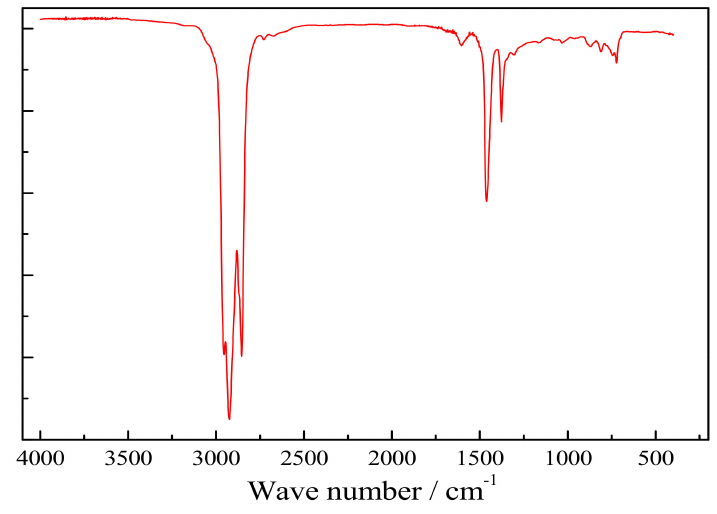
Figure 3. FT-IR spectrogram of Tarim crude